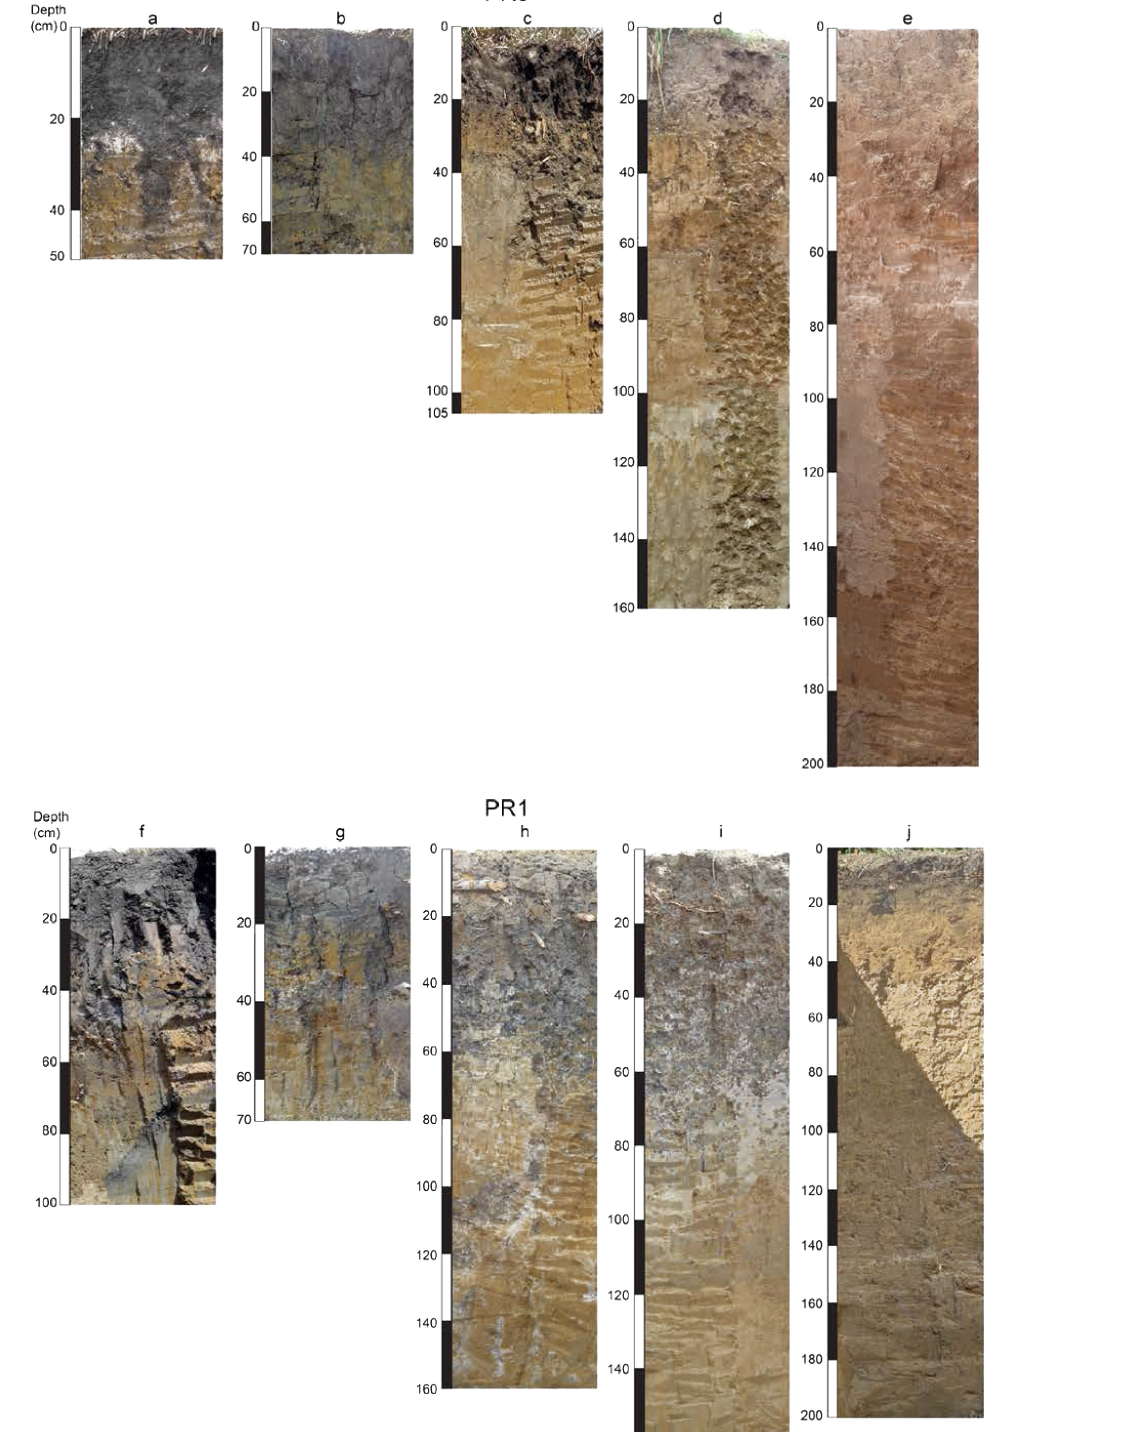
Figure 5. Photos of the profiles. Some differences in colour can be due to differences in natural light and exposure. See Table 1 for descrip-